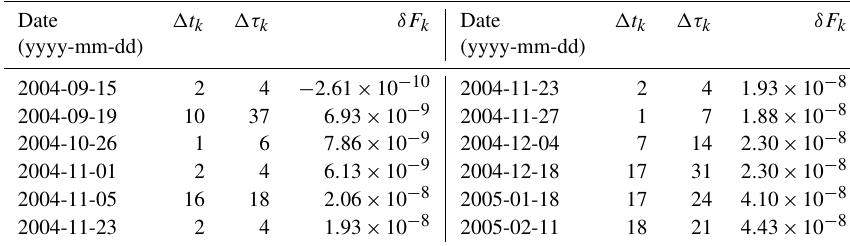
Table B2. The same as Table B1 but for the NEMO simulation period from 1 June 2004 to 31 May